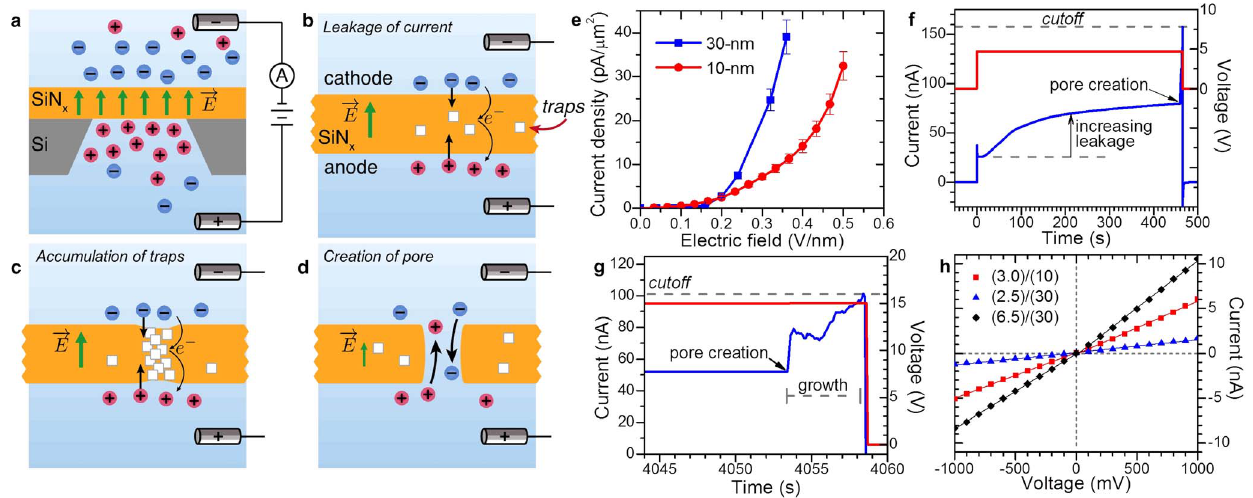
Figure 2. Nanopore formation by dielectric breakdown. a) Application of a trans-membrane potential generates an electric field inside the SiN x , and charges the interfaces with opposite ions. b) Leakage current through the membrane follows a trap-assisted tunneling mechanism. Free charges (electrons or holes) can be produced by redox reactions at the surface or by field ionization of incorporated ions. The number of available charged traps (structural defects) sets the magnitude of the observed leakage current. c) Accumulation of charge traps produced by electric field- induced bond breakage or energetic charges carries leads to a highly localized conductive path, and a discrete dielectric breakdown event. d) A nanopore is formed following removal of the defects. e) Leakage current density for SiN x membranes (50- m m 6 50- m m). The leakage current is fully reversible and stable, unless high fields are sustained, see Section S2 f) Leakage current at 5 V, on a 10-nm-thick SiN x membrane, in 1 M KCl at pH13.5. Pore created is , 5-nm (18 nS). The slowly increase leakage current, following the capacitive spike, is a result of the accumulation of traps in the membrane. g) Experiment performed at 15 V, on a 30-nm-thick SiN x membrane, in 1 M KCl pH10. The nanopore is allowed to grow until a pre- determined threshold current is reached, at which point the voltage is turned off. The observed current fluctuations at the onset of pore formation are attributed to significant low-frequency noise at this voltage. Pore created is , 3-nm (2.9 nS). h) Current-to-voltage curves for 3 nanopores fabricated on different membranes. The legend indicates the (pore diameter)/(membrane thickness) in nm. Measurements performed in 1 M KCl pH8, with an Axopatch